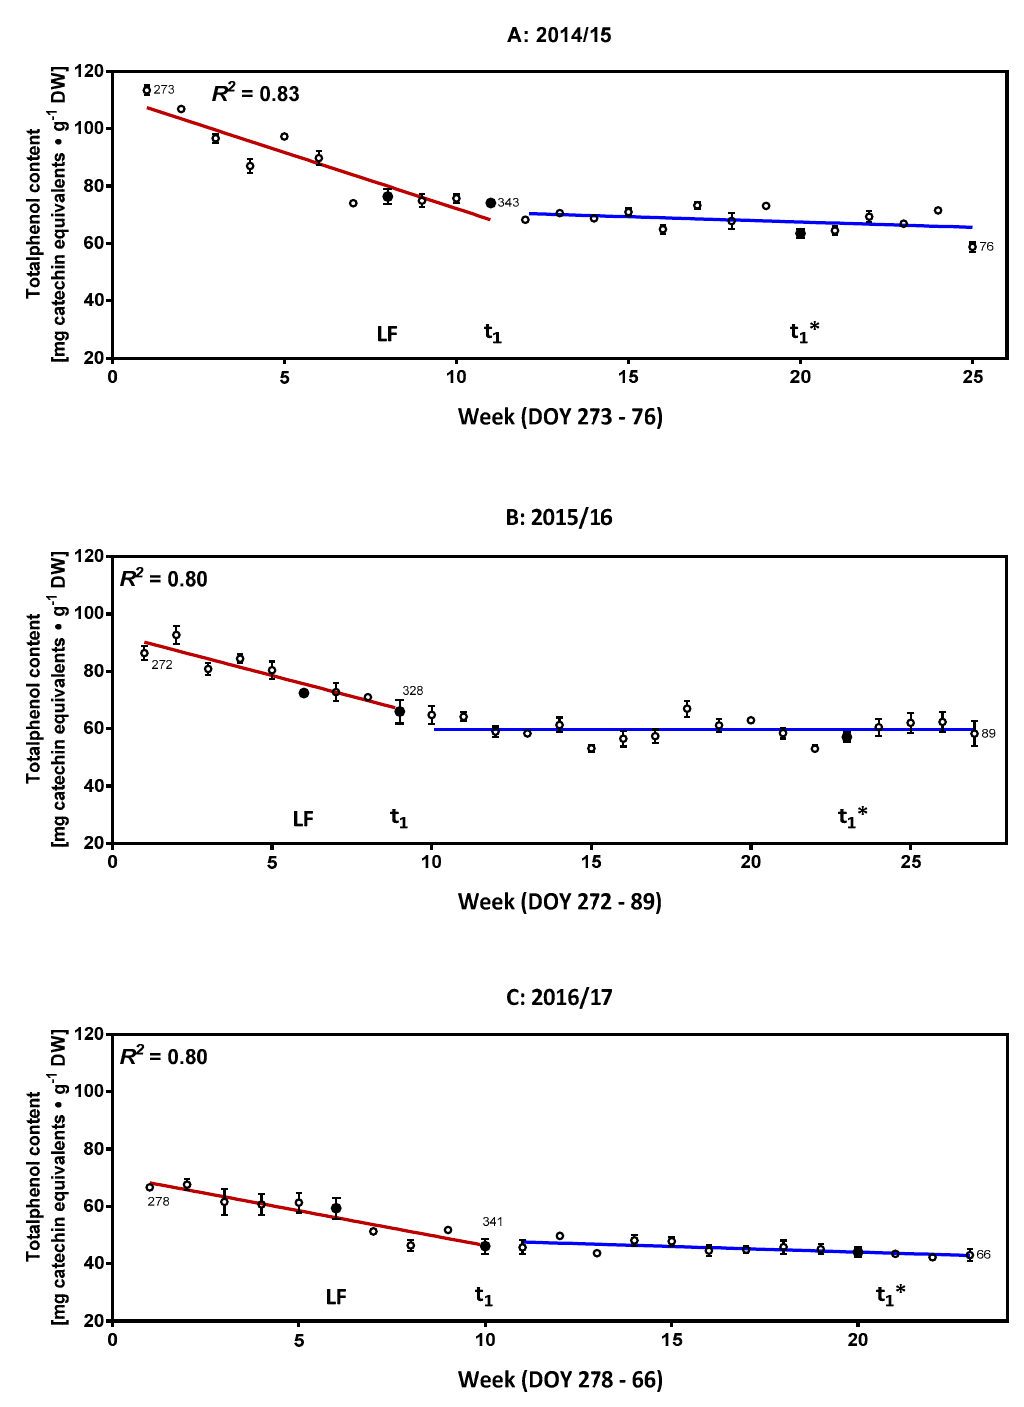
Figure 1. Weekly and developmentally orientated changes of total content of phenolic compounds. ( A ) Season 2014/15; ( B ) Season 2015/16 and ( C ) Season 2016/17. Solid black circles indicate key developmental milestones. Abbreviations: LF, leaf fall; t 1 , end of endodormancy; t 1 *, beginning of ontogenetic development; DOY, day of year; DW, dry weight.